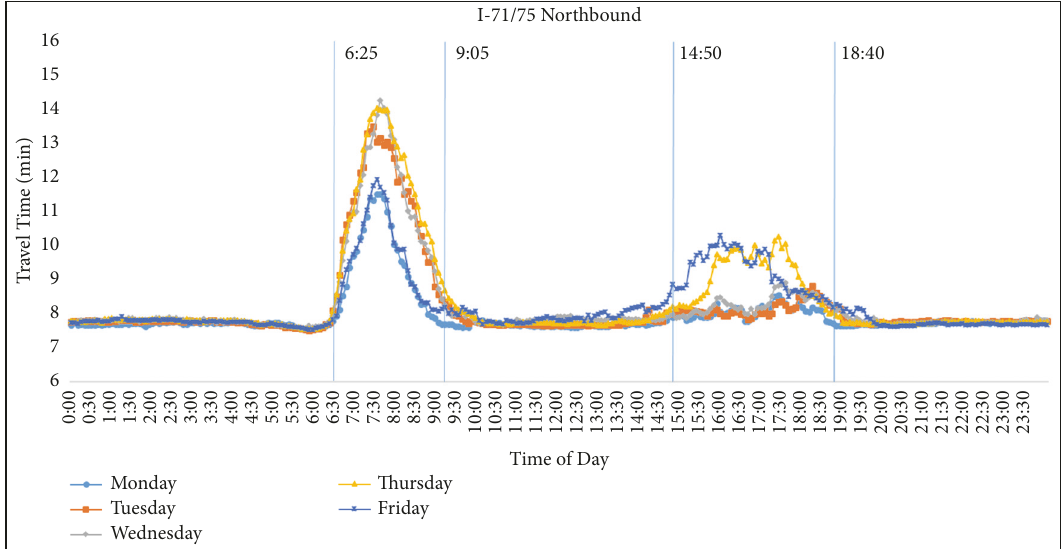
Figure 2: Travel time groups by time of day and day of